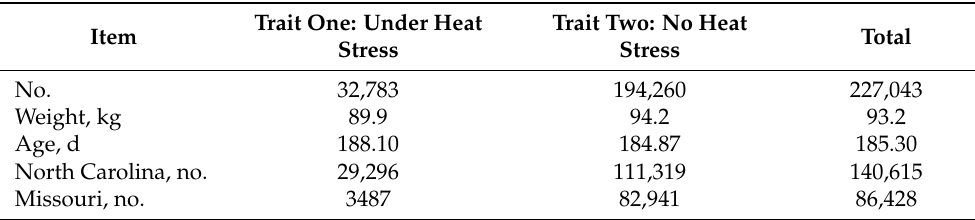
Table 1. Descriptive statistics for commercial cross animals, Duroc × F1 (Landrace × Large White), for Trait One (individuals under heat stress) and Trait Two (individuals not under heat stress) and total statistics. Note: no. refers to the number of observations. Trait One: Under Item